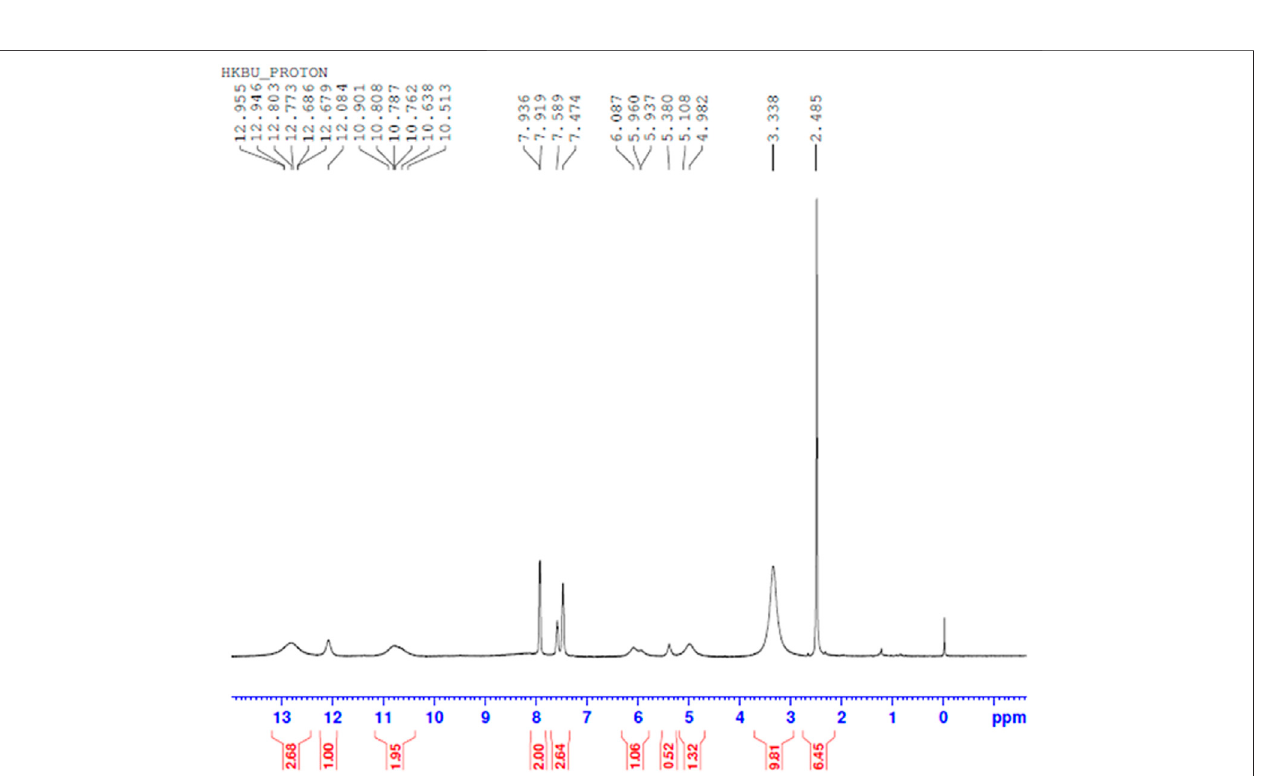
FIGURE 12 | 1 H NMR spectrum resulting from the addition of benzoic acid to ferric sulfate and chromium sulfate mixed solution at 30 ° C.